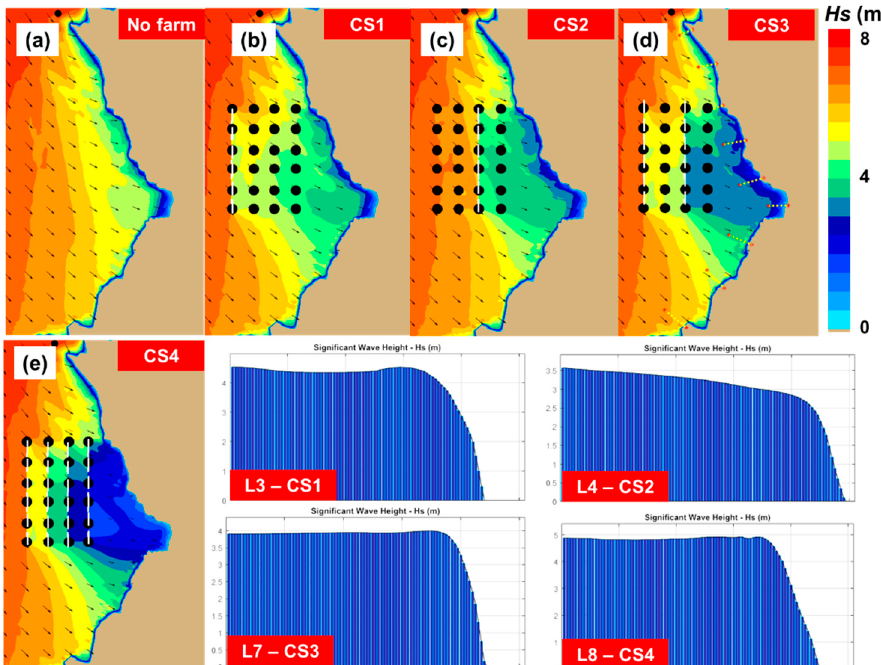
Figure 9. Influence of the generic marine farm taking into account an extreme winter event (case